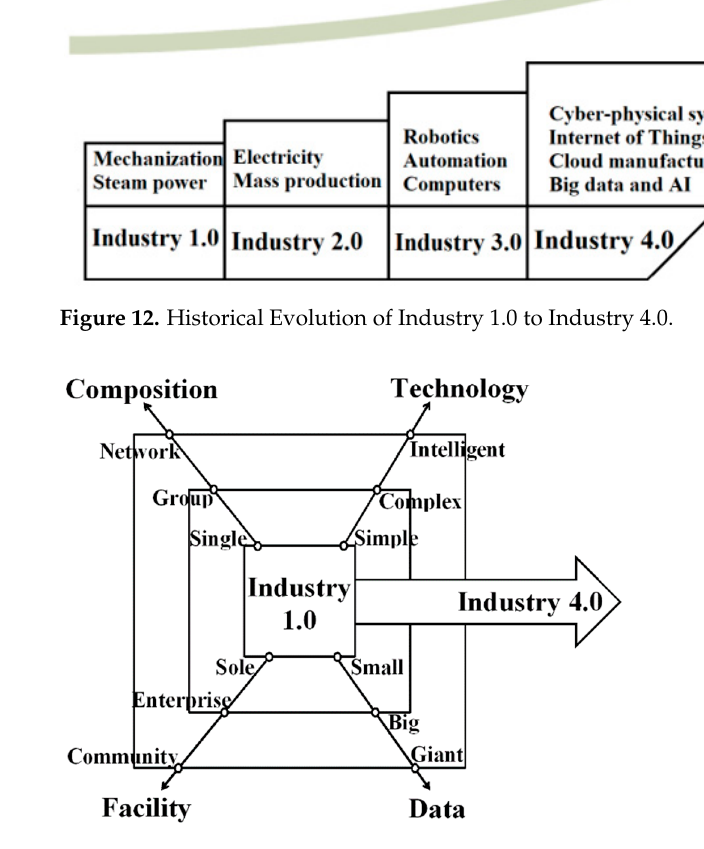
Figure 13. Characteristics of Industry 1.0 to 4.0.